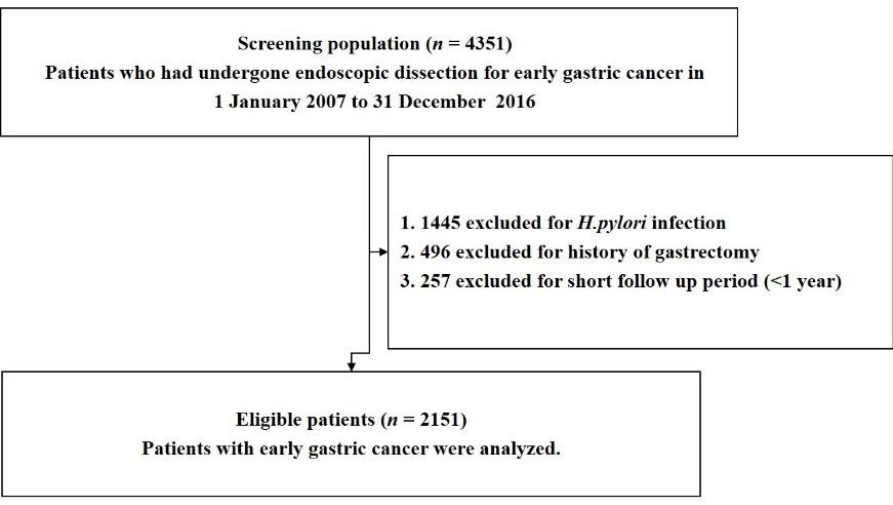
Figure 1. Flowchart of patient enrollment.